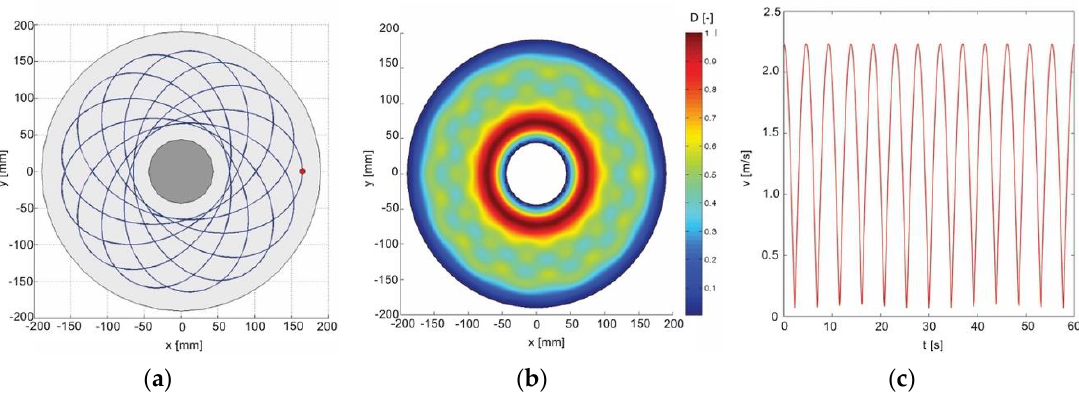
Figure 4. The influence of the parameter k 1 = 13 / 9 on: ( a ) the shape of the abrasive grains trajectory; ( b ) the trajectories density on the lapping plate; and ( c ) the distribution of relative velocities v ( t ). Table 1. Cycle duration for di ff erent parameters k 1